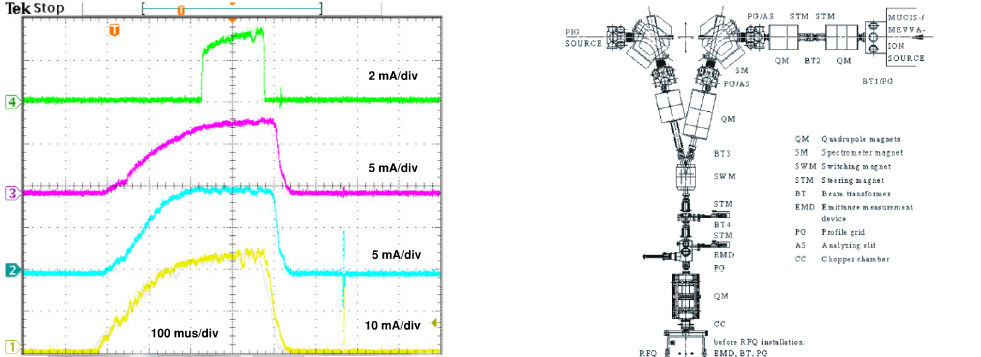
Figure 11. ( Left ): Signals from four beam transformers showing the same ion beam pulse along a 12m long beam line. Behind a chopper SCC which needs to be rebuilt, requiring additional time. ( Right ): beam line from acceleration gap to the RFQ. QM magnetic quadrupole, SM spectrometer magnet, SWM swiching magnet (between beam lines), BT beam